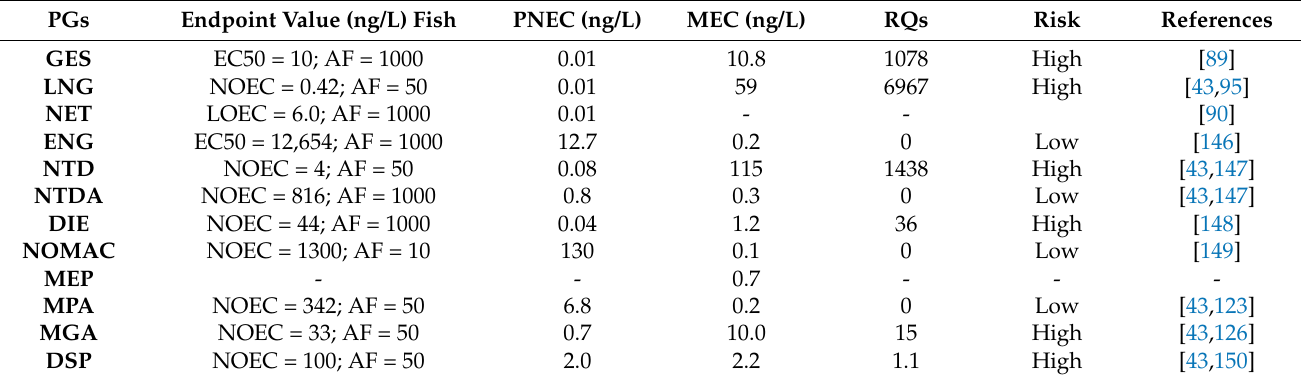
Table 8. Risk quotients (RQs) for 9 of the 12 PGs referred to in this study using the considering the average between the minimum and the maximal levels found in surface waters from 2015 to